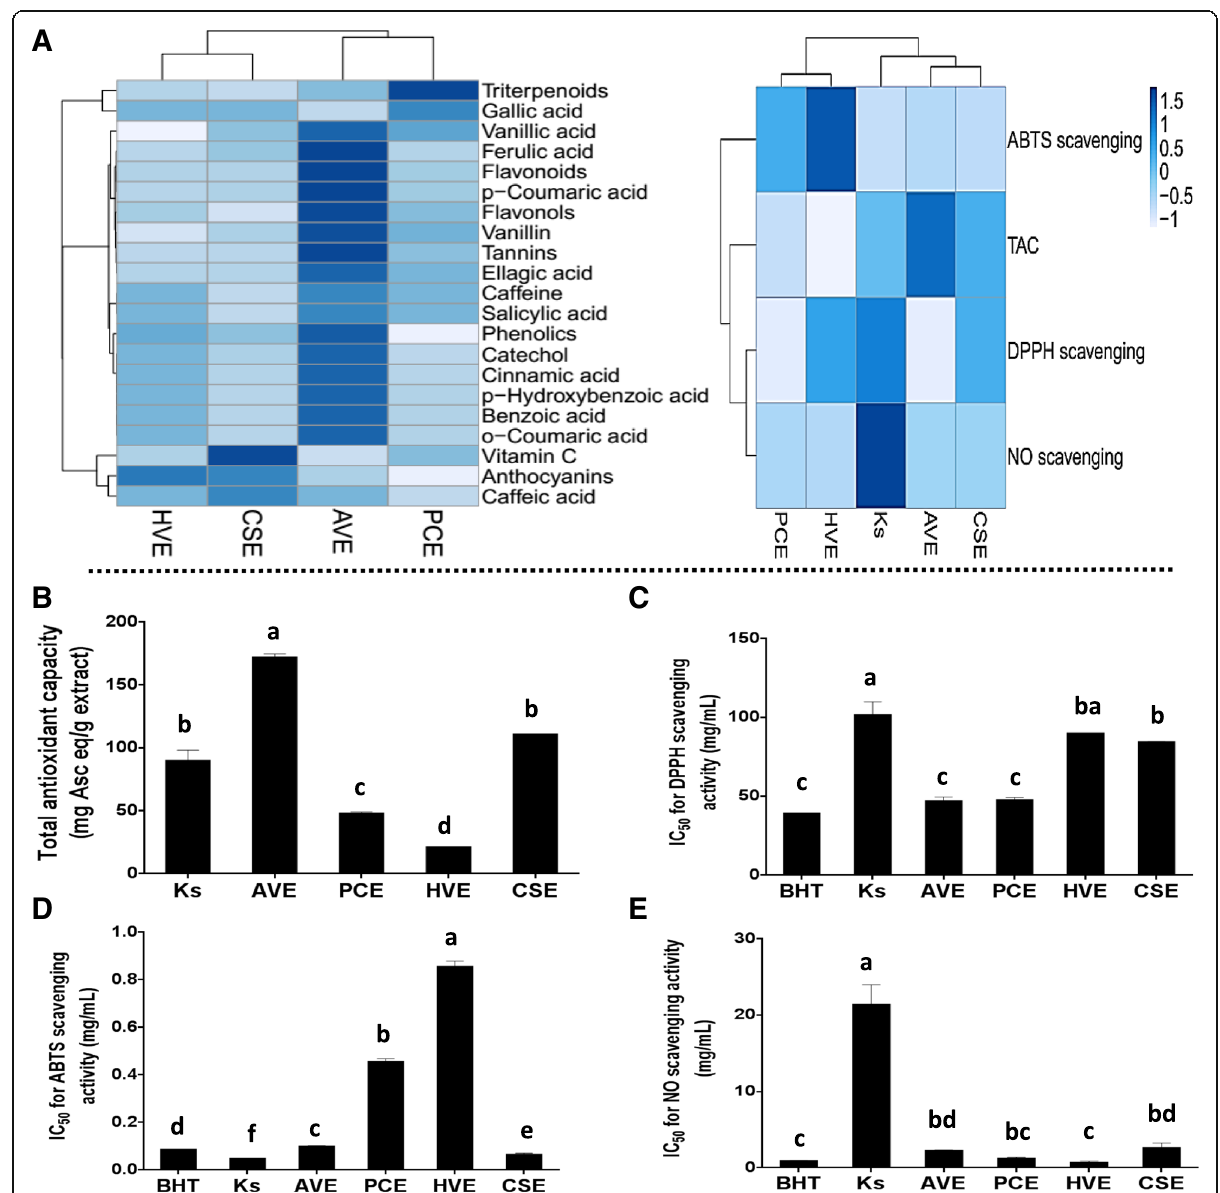
Fig. 2 Antioxidant activities of Ammi visnaga (AV), Petroselinum crispum (PC), Hordeum vulgare (HV), and Cymbopogon schoenanthus (CS) extracts in comparison with the Ketosteril (Ks) and butylated hydroxytoluene (BHT). ( a ) Heat map distribution of the phytochemical content and in vitro antioxidant activities of the four studied extracts, the color distributed from white (low concentrations) to blue (high concentrations) ( b ) Total antioxidant capacity ( c ) α , α -Diphenyl- β -picrylhydrazyl (DPPH) scavenging activity ( d ) 2,2-azino-bis (3-ethylbenzthiazoline-6-sulfonic acid (ABTS) scavenging activity ( e ) Nitric oxide (NO) scavenging activity. Results are presented as mean ± SE ( n = 3). Different letters for the same parameter are significantly different at p <